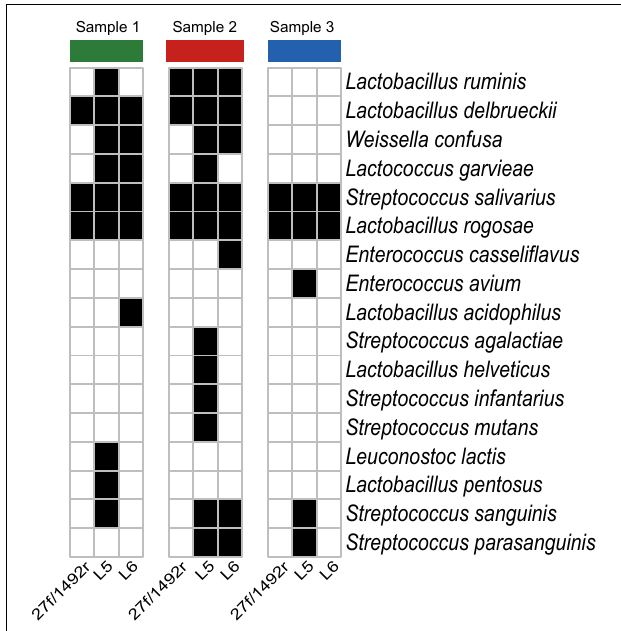
FIGURE 3 | Species of bacteria identified in fecal samples using candidate primers after standardizing the sequence counts across samples. Three fecal DNA samples were amplified using the universal bacteria primer 27f and LAB-specific primers L5 and L6 and then sequenced using SMRT sequencing. A heatmap was created according to the presence (black squares) and absence (white squares) of the target LAB bacteria at the species level after standardizing sequence counts across